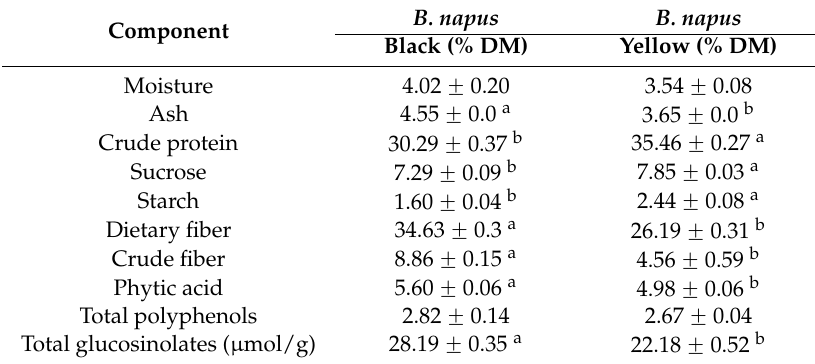
Table 1. Chemical composition of black- and yellow-seeded B. napus seed